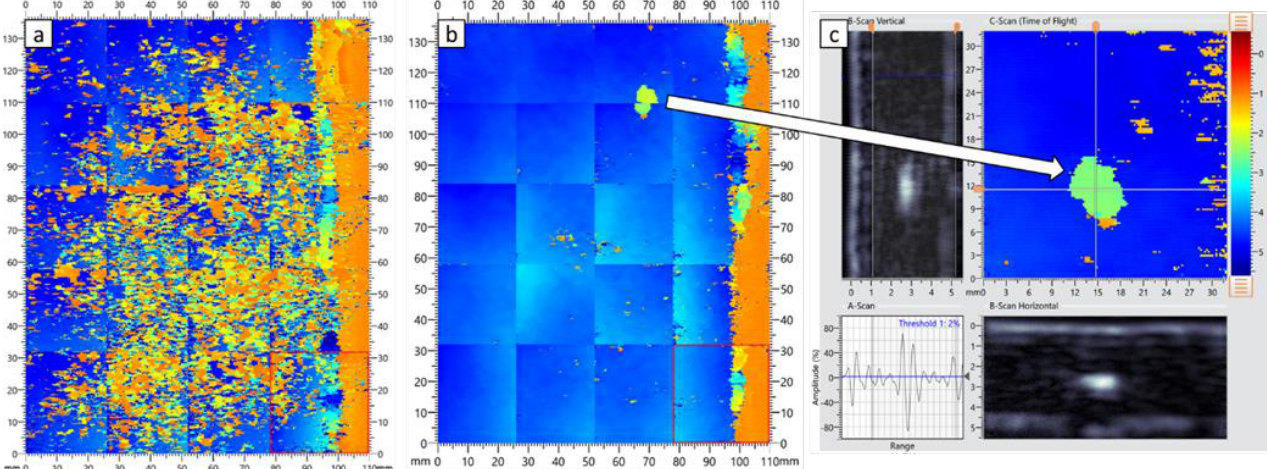
Figure 19. 3R laminate ( a ) initial, ( b ) repaired, and ( c ) a-scan, b-scan, and c-scan of defects.